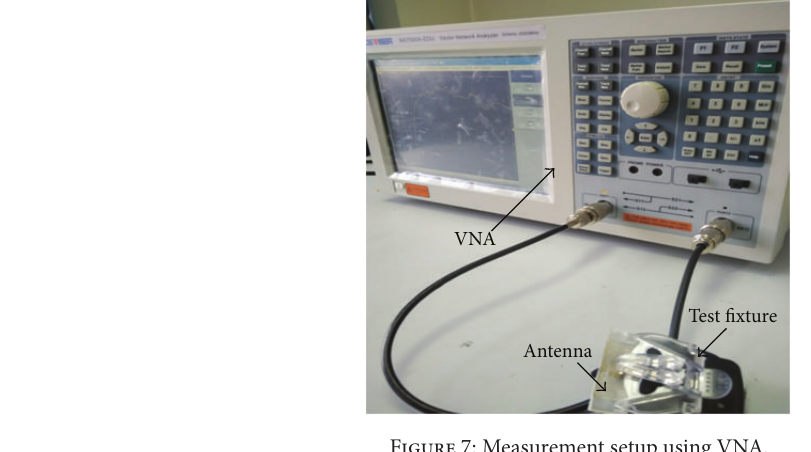
Figure 7: Measurement setup using VNA.